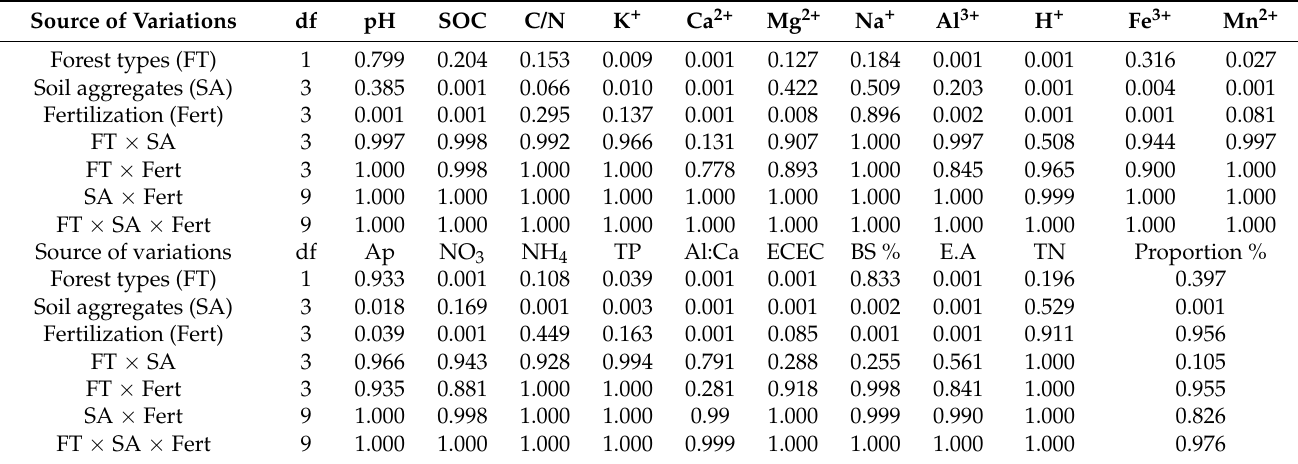
Table 3. Two-way ANOVA results of forest types, soil aggregates, fertilization, and their inter- actions on the soil chemical properties, in three replications of the broad-leaved Korean pine for- est and Korean pine plantations at four combined (NP) levels of fertilization (CK, 0 g N, and